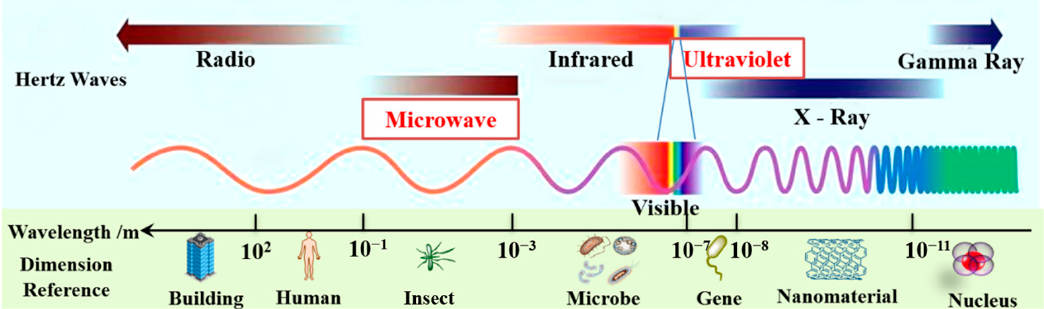
Figure 1. The wavebands of microwave and ultraviolet in the electromagnetic waves.